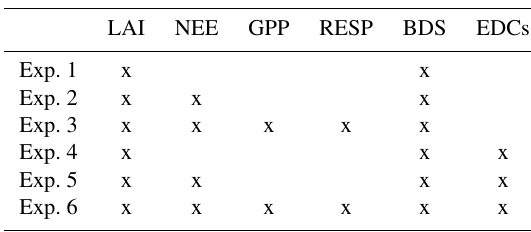
Table 3. Experiment set up summary: in Exp. 1 we use LAI and bounds constraints (BDS), in Exp. 2 we use LAI, NEE and BDS and so